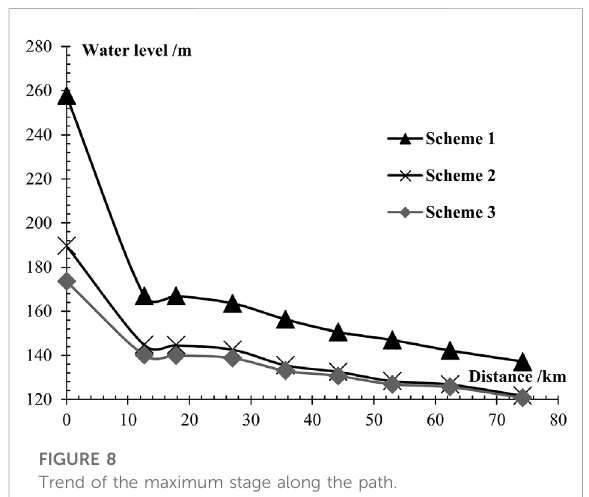
FIGURE 8 Trend of the maximum stage along the